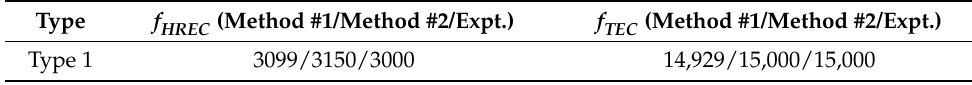
Table 2. Peak frequencies comparison of type 1